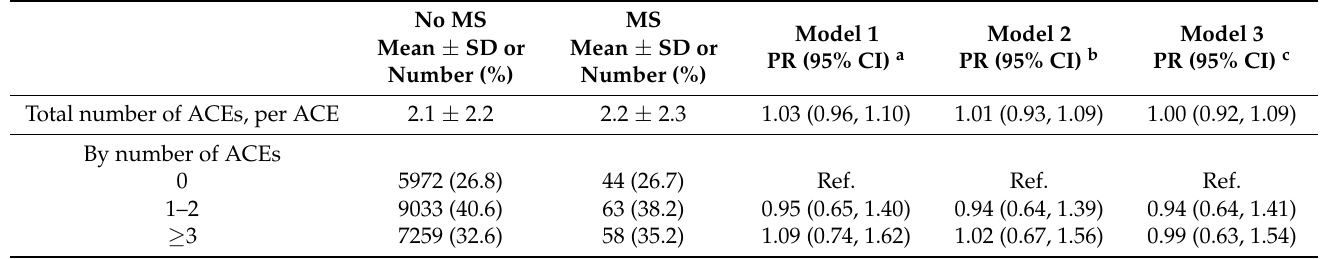
Table 2. Associations between number of and cumulative exposure to adverse childhood experiences (ACEs) and multiple sclerosis (MS) among women in the SAGA Cohort. MS No MS Model Mean ± SD or Mean ± SD or Number (%) Number (%)